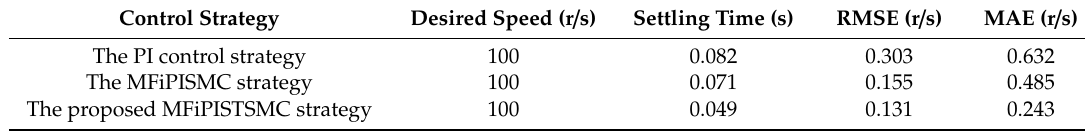
Figure 3. ( a ) Speed response curves with ω r = 100 r / s without load starting and stable operation; ( b ) detailed view of the image ( a ). Table 2. The comparative results of the speed response curves without Table 3. The comparative results of the speed response curves with load.